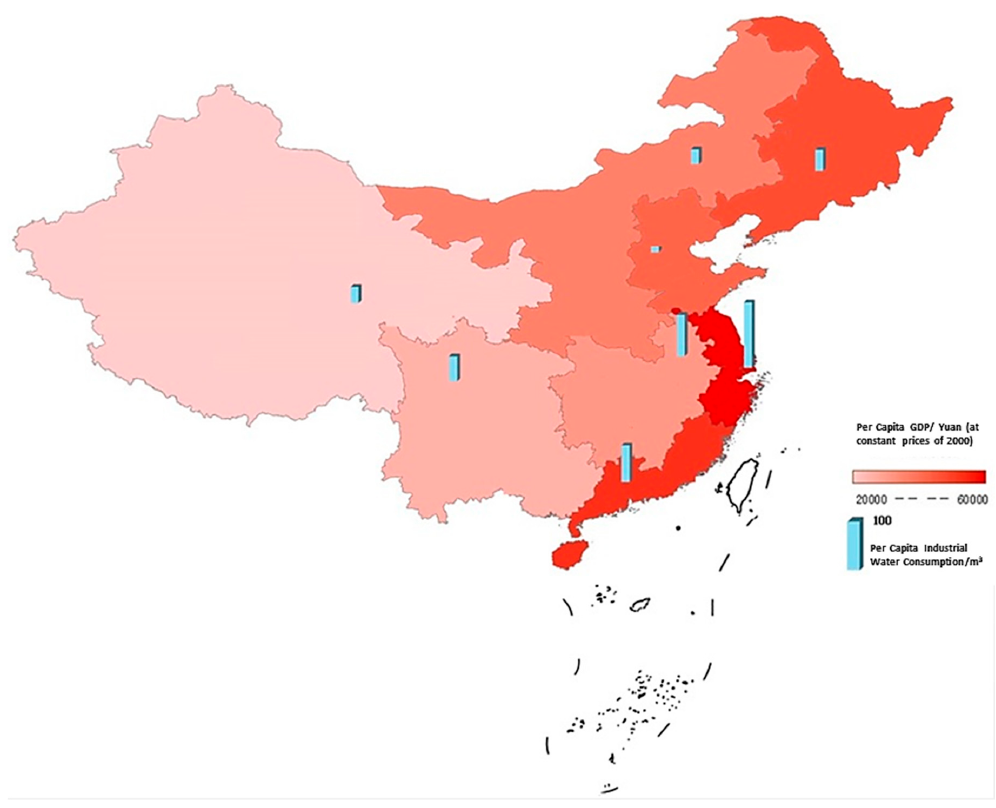
Figure 1. Relationship between per capita industrial water use and GDP of eight economic zones in China (2014).